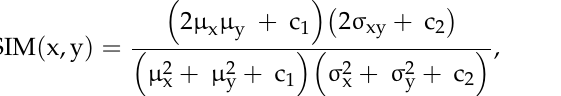
2 Ranked accuracy: Rank-1, Rank-5, and Rank-N are used to measure the performance of DNNs in computer vision. Rank-1 accuracy finds the percentage of correctly classified labels. Rank-5 accuracy is mostly used when there are more than two class labels, which aims to check when the top five most probable labels have the ground truth value. The Rank-N accuracy is similar to Rank-5, but usually used with larger datasets [179]. 3 Precision: The ratio of correctly classified positive predictions, which can be defined as follows: 4. Mean average precision (mAP): A popular performance measurement metric used in computer vision, specifically for object detection, classification, and localization. It can be generally calculated by taking the mean average precision over all classes and the overall intersection over union (IoU) thresholds [180]. 5. Structural similarity index (SSIM): Used to measure the observed quality of digital images and videos. Moreover, it is applied for estimating the similarity between two images. The measurement or prediction of image quality is based on an initial uncompressed or distortion-free image as a reference, and therefore the SSIM index is considered as a full reference metric. It can be defined as follows: